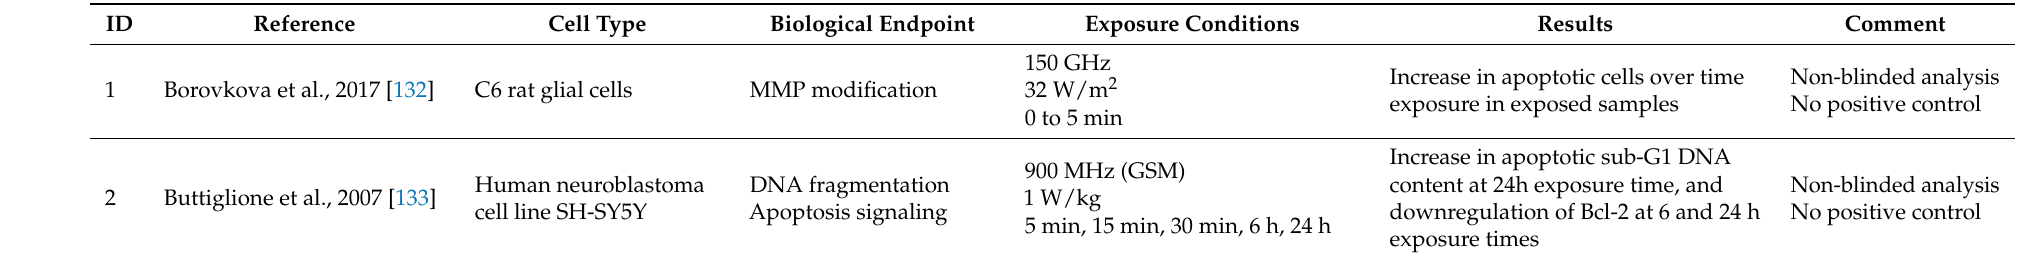
Table 4. Overview of studies that reported statistically significant alteration of the apoptotic process following RF-EMF